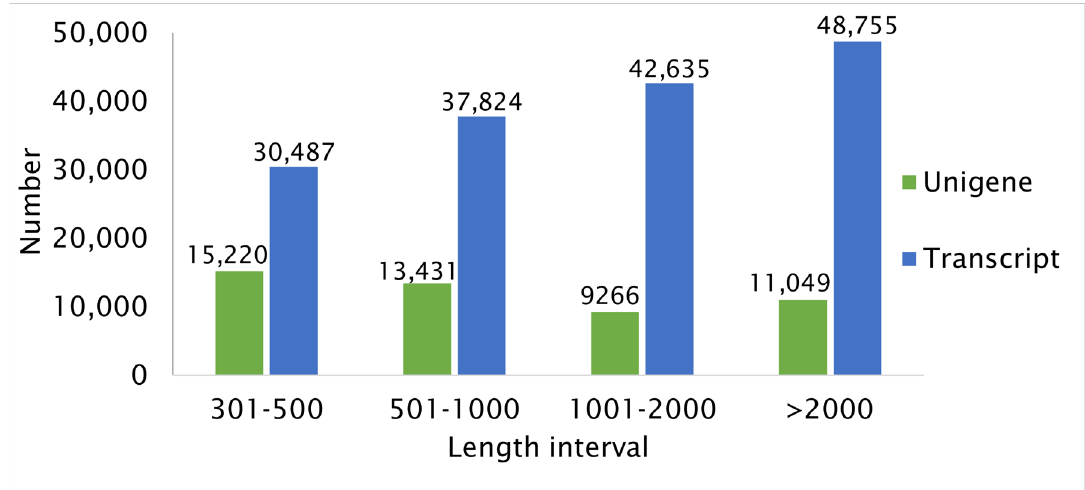
Figure 1. Length distribution of the assembled transcripts and unigenes from the transcriptome of R. nigrum cv. Aldoniai. R. nigrum cv.